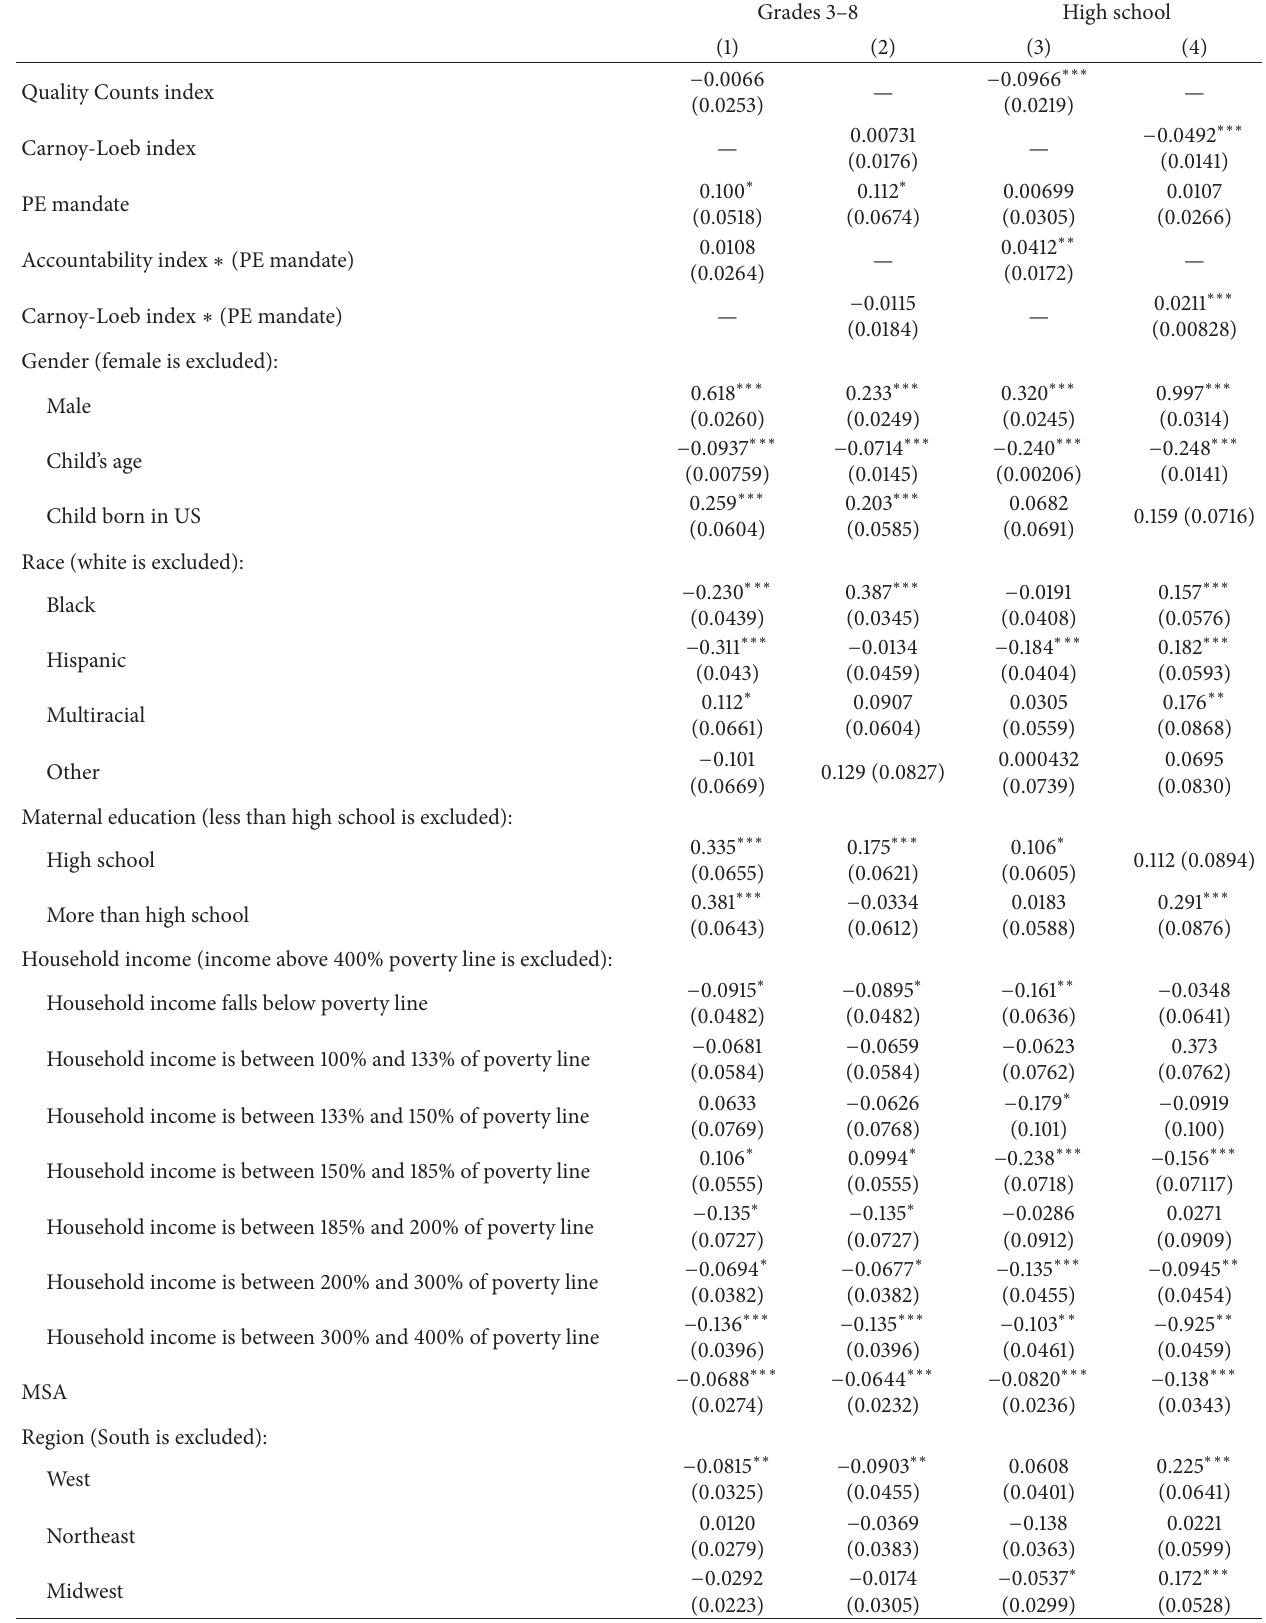
Table 3: Empirical results: effect of accountability pressures on days of vigorous physical